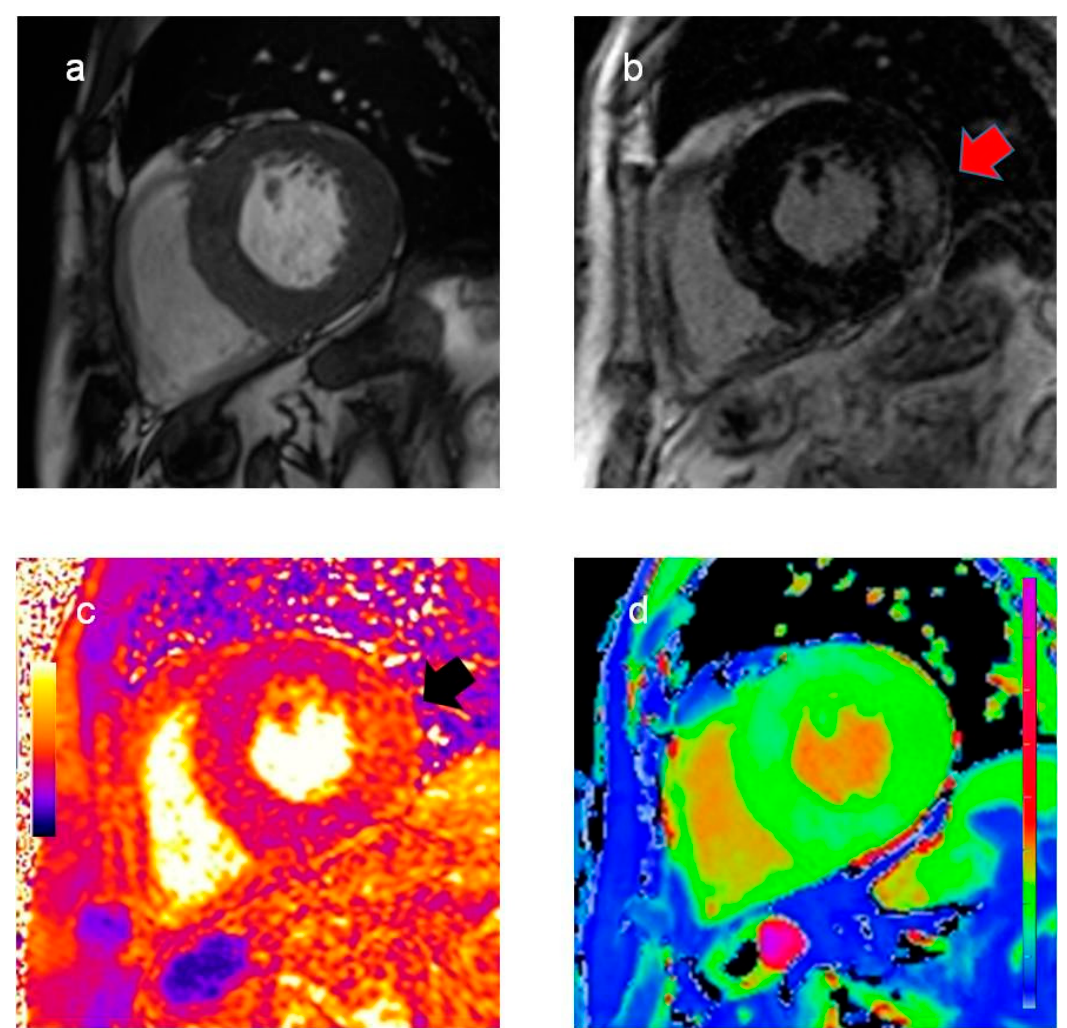
Figure 1. Cardiac magnetic resonance findings. Cine ( a ) and late gadolinium enhancement images ( b ), T2 ( c ), and T1 map ( d ) in basal short-axis view. Significant biventricular hypertrophy with extensive late gadolinium enhancement in the infero-lateral wall (( b ), red arrow). Increased T2 values in the infero-lateral wall (( c ), black arrow) indicate myocardial inflammation. Reduced native T1 values ( d ), suggesting myocardial glycosphingolipid storage, are a typical finding in Fabry disease.